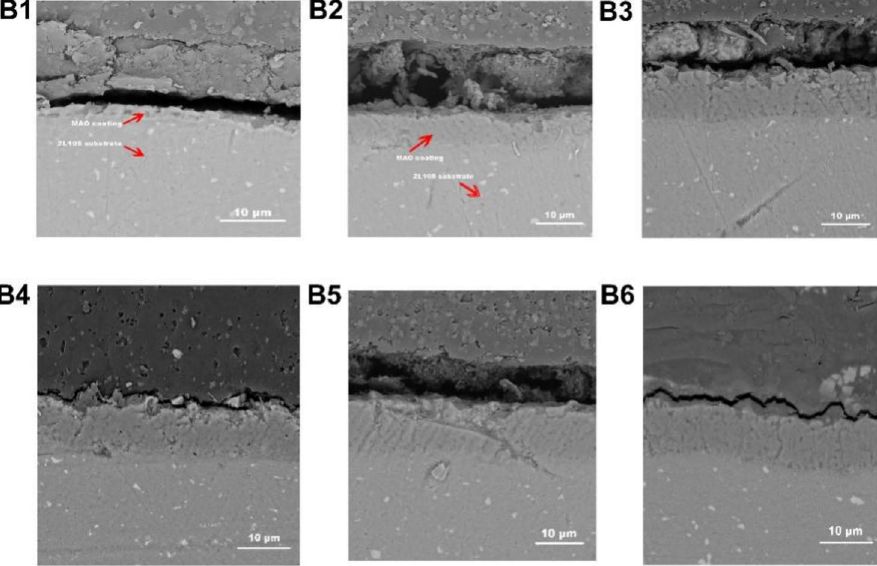
Figure 3. The cross-section morphologies of the MAO coatings ( B1 ): The concentration of NCNs is 0 g/L; ( B2 ): 0.4 g/L; ( B3 ): 0.8 g/L; ( B4 ): 1.2 g/L; ( B5 ): 1.6 g/L; ( B6 ): 2.0 g/L; Adobe Illustrator CS5, https:// www. adobe. com/ cn/ produ cts/ illus trator. html# scroll).